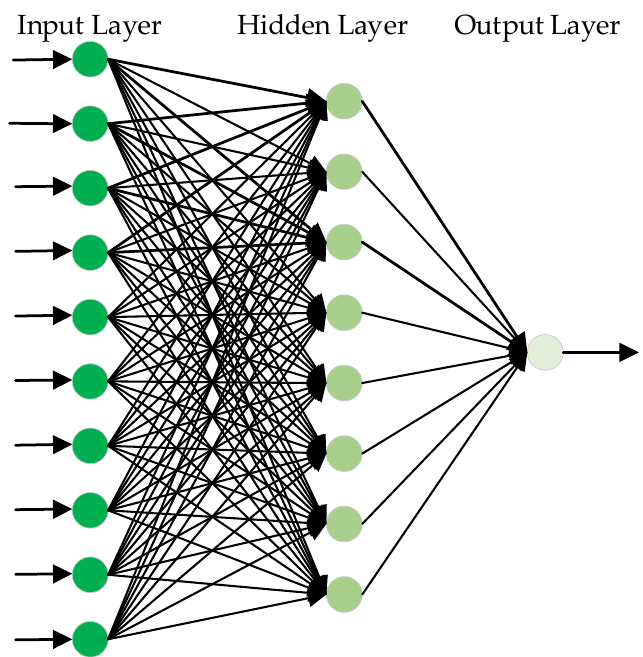
Figure 3. The structure of a BP network (10-8-1).